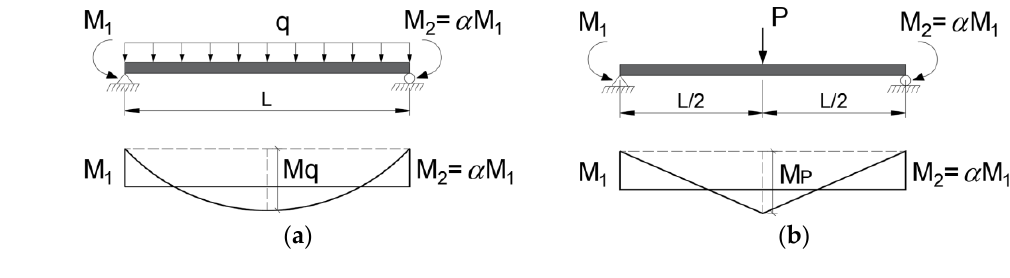
Figure 4. Loading conditions. ( a ) LC 1 , ( b ) LC 2 .